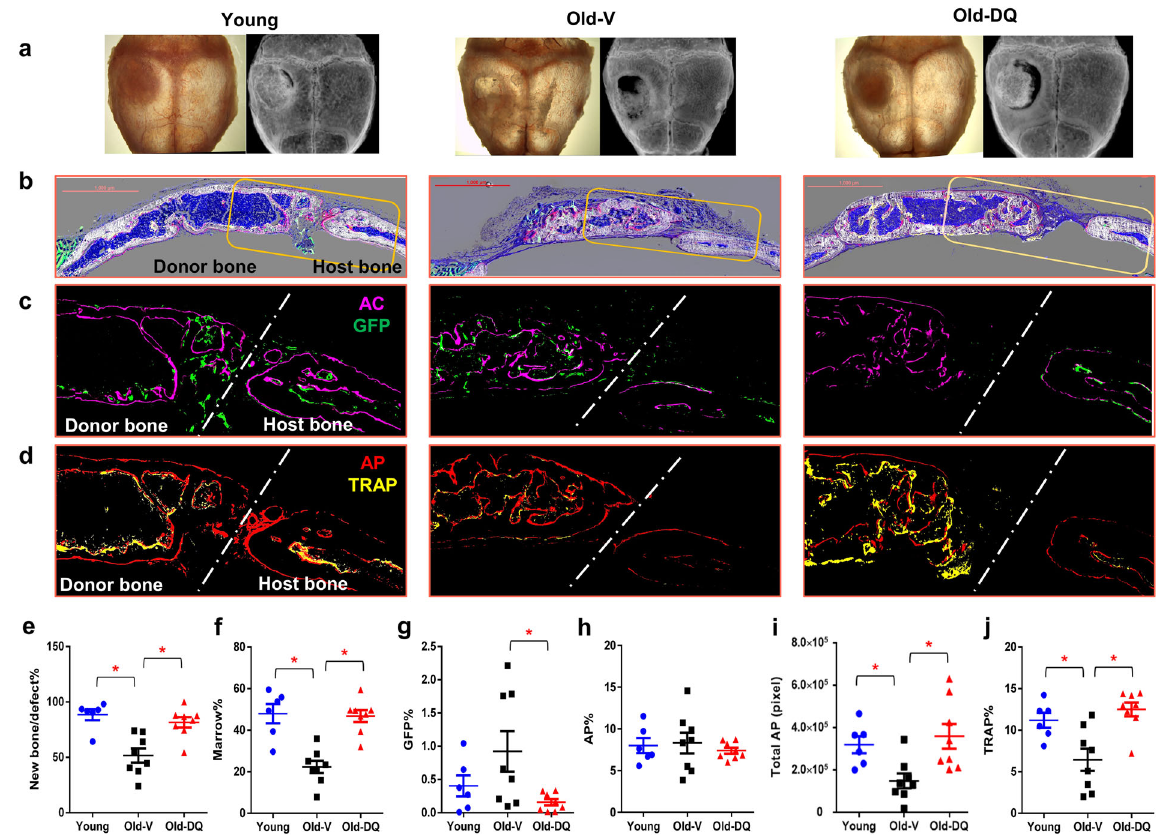
Fig. 2 D + Q improved osteogenic capacity of old BMSCs in vivo. a Representative pictures and X-ray images of the whole calvarial defects. b Representative multimodal histological images of calvarial defects with mineral (white), AP (red), TRAP (yellow), GFP (green), AC (purple), TB (dark blue) and DAPI (blue) staining. Scale bar: 1000 μ m. Enlarged images of calvarial defects with ( c ) AC + GFP signal and ( d ) AP + TRAP staining. e New Bone Area as percentage of the Defect Area. f Marrow area as percentage of the total cortical shell area. g GFP area as percentage of the total cortical bone area. h AP linear surface area as percentage of the total cortical bone area. i Total AP linear surface area. j TRAP linear surface area as percentage of the total cortical bone area. Results were shown as means ± s.e.m. n = 6 for Young, n = 8 for Old-V, n = 8 for Old-DQ. * p < 0.05; two-tailed, unpaired Student ’ s